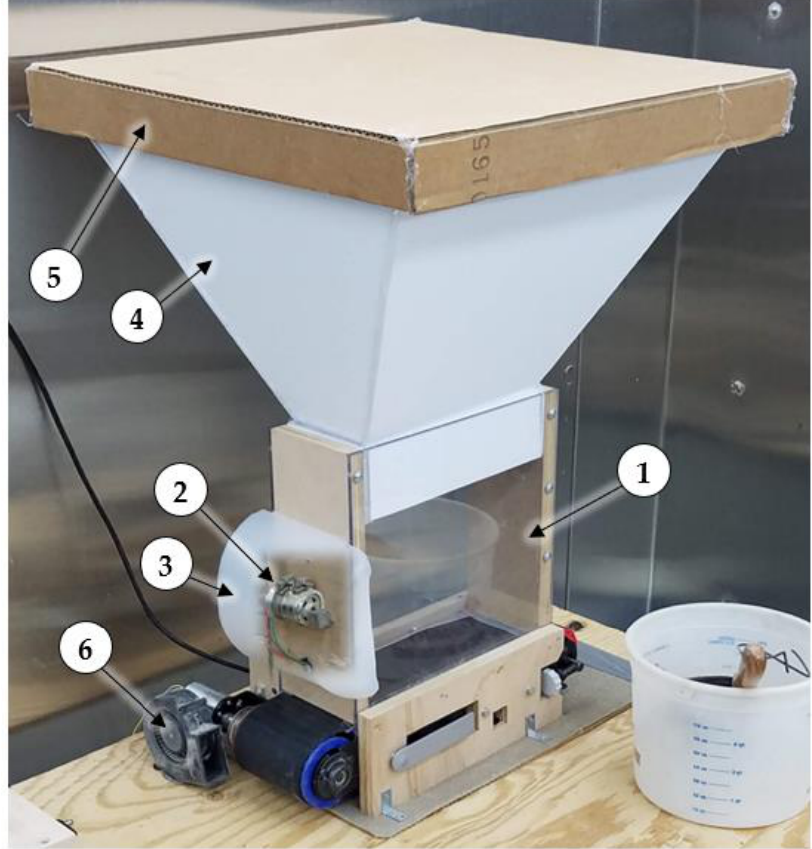
Figure 8. Assembled dust generator: (1) hopper, (2) vibratory motor, (3) safety shield, (4) hopper extension, (5) lid, and (6) centrifugal blower.